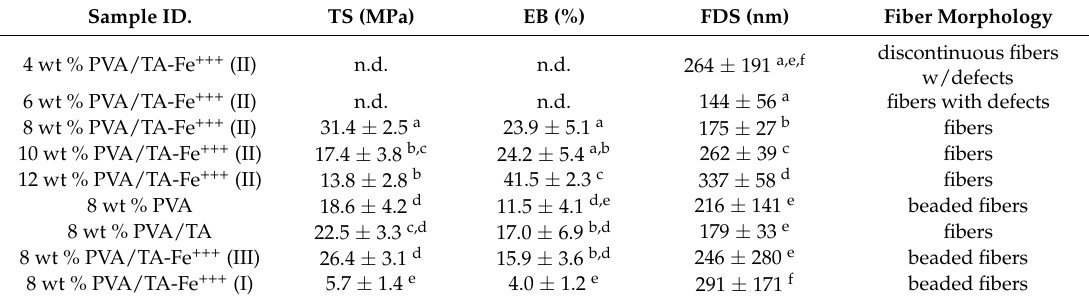
Table 2. Mechanical properties (tensile strength, TS (MPa); elongation-at-break, EB (%)) of the nanofiber mats prepared from the spinning solutions listed in Table 1. Mats were prepared with variable PVA concentration and fixed amount of TA-Fe +++ complexes. Nanofiber mats of 8 wt % PVA and 8 wt % PVA/TA were used as control